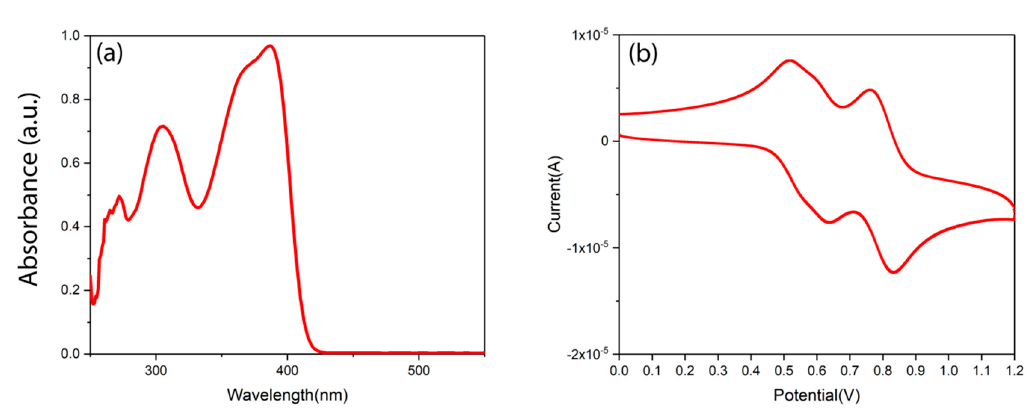
Figure 2. ( a ) Ultraviolet–visible (UV–Vis) spectrum of 2,2’,7,7’-tetrakis[N,N-di(4-methoxyphenyl)amino]-9,9’-spirobifluorene (Spiro) in chlorobenzene solution; ( b ) cyclic voltammetry curve of Spiro in acetonitrile solution.